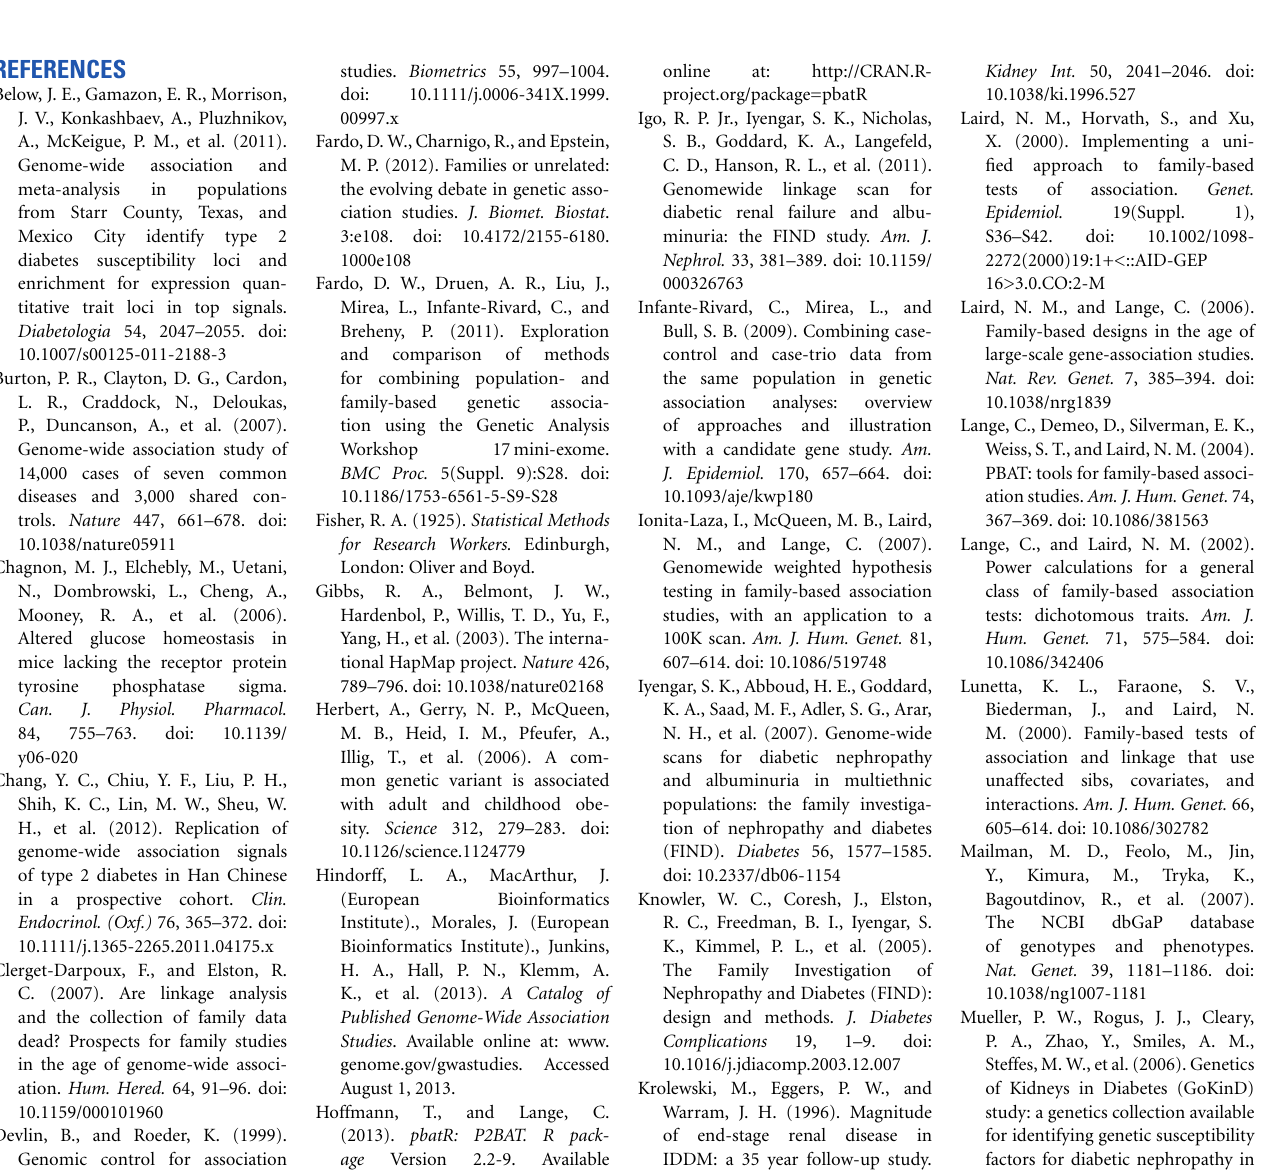
Figure S3 | Projection of principal components of population-based GoKinD subjects onto HapMap populations. A pruned set of SNPs (85,051) from the population-based cases and controls were projected onto a similar set of SNPs from the original three International HapMap populations [GoKinD subjects in blue, (A) ]. Using Z -scores based on median absolute deviation, a homogenous population was selected for association analysis [selected GoKinD population shown in blue and outliers in red, (B) ]. HapMap populations: CEU (Eastern and Western European) samples are shown in green, YRI (Yoruba in Ibadan, Nigeria) are in black, and JPT + CHB (Japanese in Tokyo, Japan and Hans Chinese in Beijing) are shown in